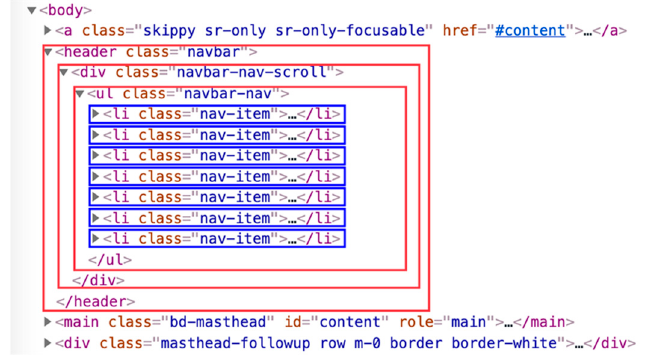
Figure 3. An example of HTML block variations, where red blocks can be considered as containers and all three cases can be assumed as correct bounds of the